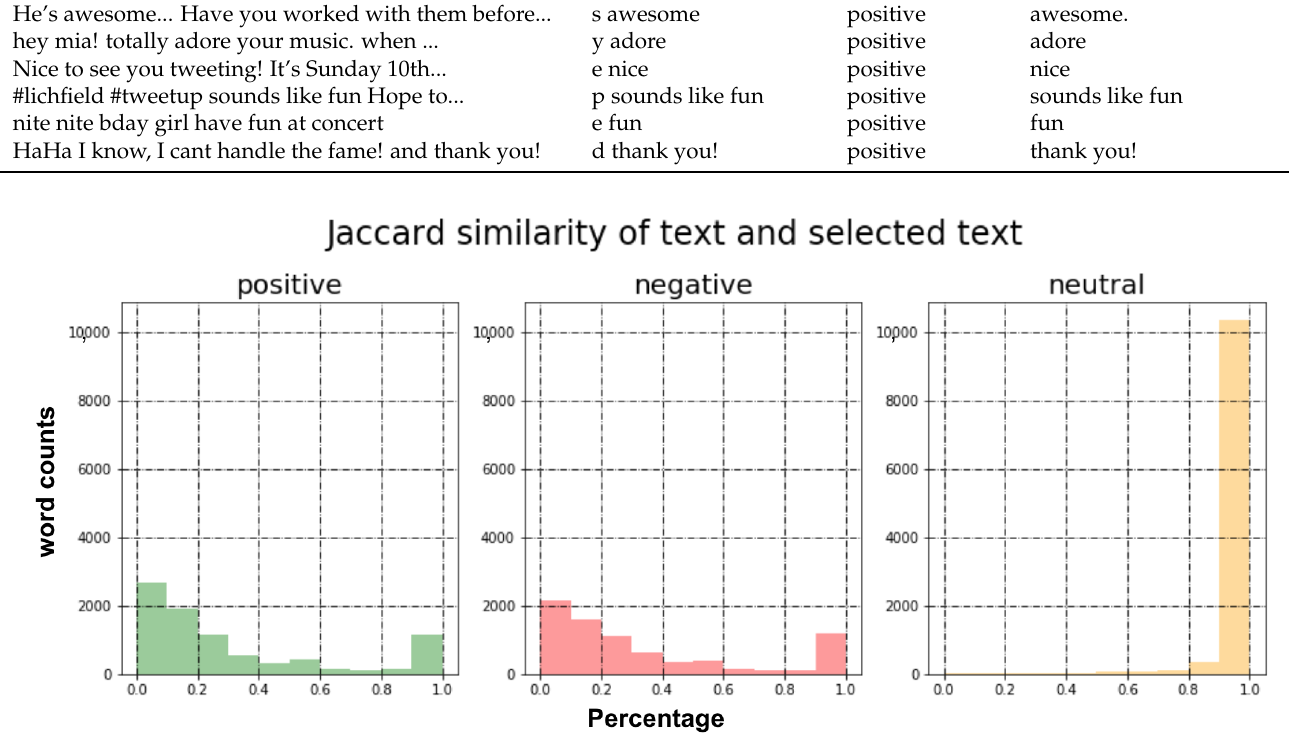
Figure 6. These plots display Jaccard similarity between input sentence and selected subsentence for each sentiment in the dataset. x-axis is the similarity percentage and y-axis is the number of sentences holding the corresponding similarity. Noticeably, sentences with neutral sentiment have the identical subsentence whereas sentences with positive and negative show similar